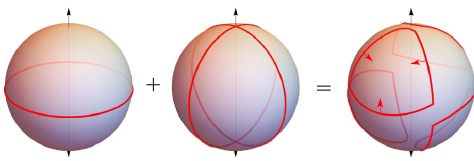
FIG. 3. In the presence of the fourfold rotoinversion S 4 only, the equator and the hinge state are deformable into each other since their sum can be trivialized, as shown